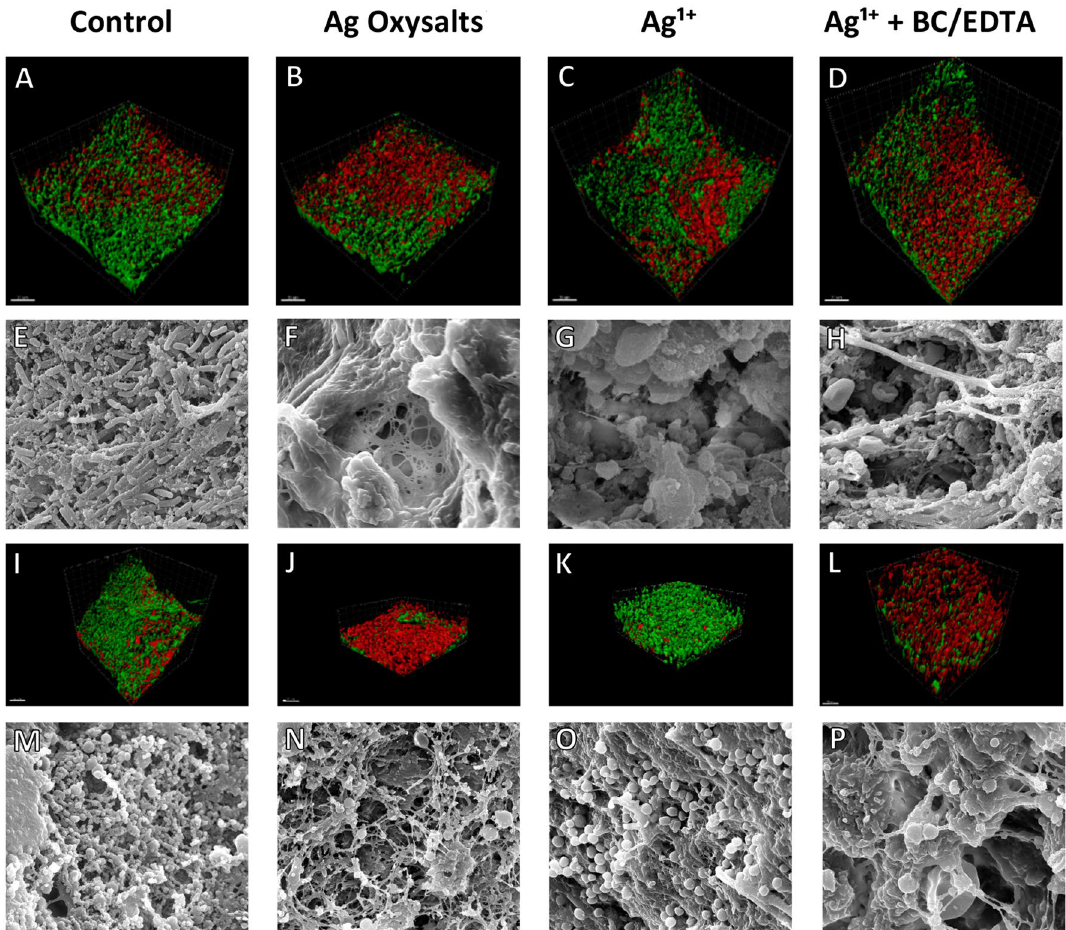
Figure 4. Visualisation of in vivo wound biofilms after 3 days treatment with control or silver dressings. Confocal images of P. aeruginosa ( A – D ) and S. aureus ( I – L ) stained with Toto 1 (green) to visualise the extracellular nucleic acids, a component of the biofilm’s extracellular polymeric substance, and Syto 60 (red) which stains intracellular nucleic acids. P. Scanning electron microscopy of P. aeruginosa ( E – H ) & S.